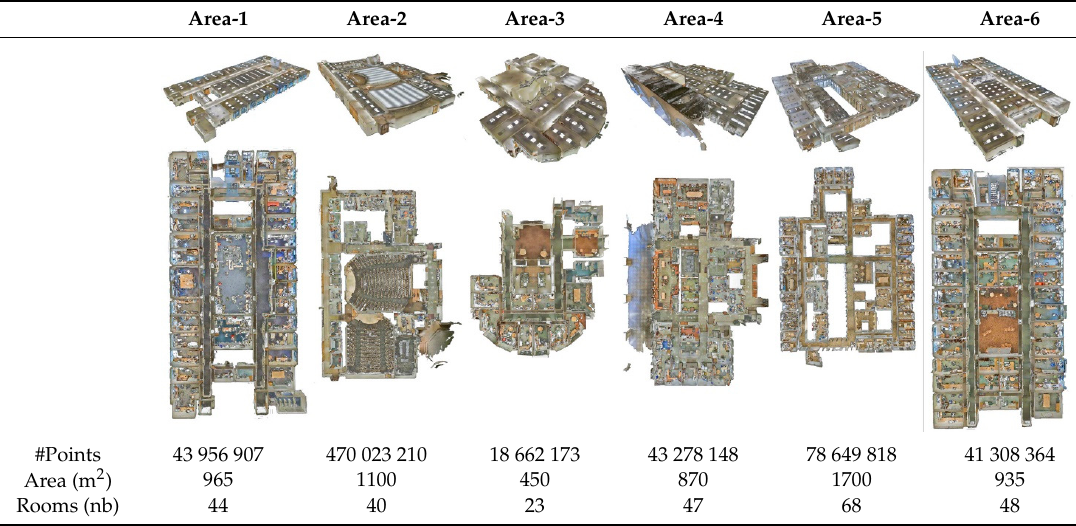
Table 5: S3DIS per-area statistics regarding the studied